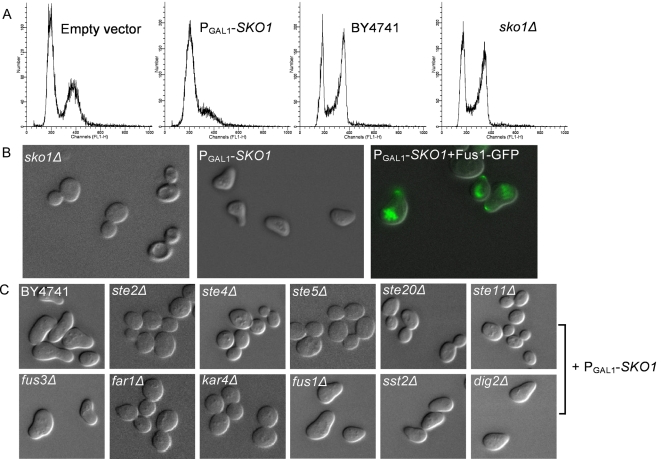
Overexpression of SKO1 activates the pheromone response pathway.(A) shows flow cytometry analysis of DNA content for the empty vector control strain, PGAL1-SKO1 strain, and the sko1Δ strain with its corresponding control strain. Overproduction of SKO1 causes a strong arrest at the G1 phase (78% of PGAL1-SKO1 cells accumulated at the G1 phase vs. 58% of control cells at the G1 phase). In contrast, there was no obvious G1 arrest in the sko1Δ strain. (B) While the sko1Δ strain exhibits a typical yeast cell morphology, cells from the PGAL1-SKO1 strain resemble yeast cells presented with mating pheromone (shmoos). Overexpression of SKO1 in cells expressing a green-fluorescent protein-tagged version of the mating projection marker Fus1 induces Fus1-GFP localization to the tip of the projection (shown as an overlay of the GFP channel on the DIC image), consistent with SKO1 overexpression inducing shmooing. (C) SKO1 induces shmooing when overexpressed in the deletion strains fus1Δ, fus3Δ, sst2Δ, and dig2Δ, as well as in the corresponding parental strain (BY4741), but not when overexpressed in the deletion strains ste2Δ, ste4Δ, ste5Δ, ste20Δ, ste11Δ, far1Δ, and kar4Δ, indicating that the latter genes are required for SKO1-induced shmoo formation.